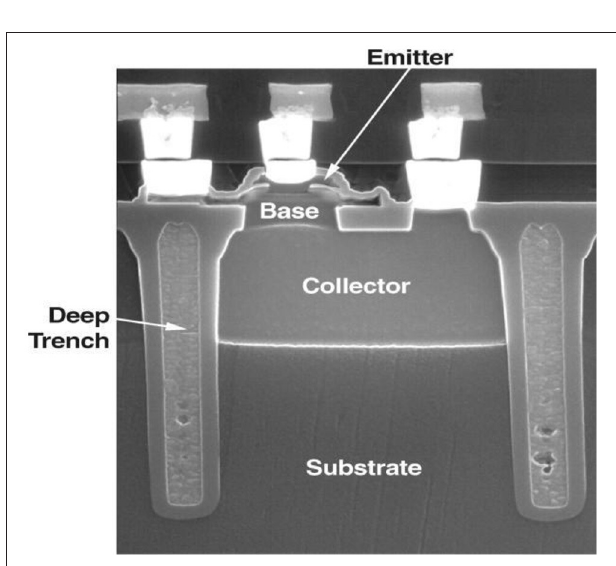
FIGURE 11 | Silicon on insulator (SOI) protection device for 0.25 µ m SOI technology (with permission of the ESD Association).